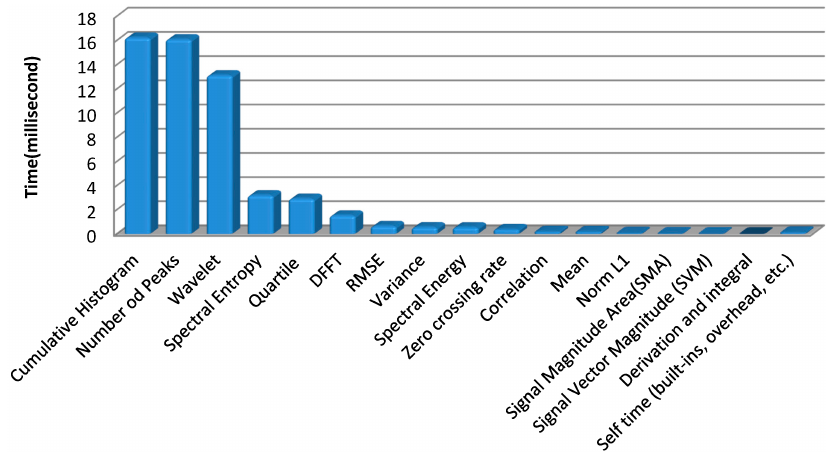
Figure 10. Time efficiency of feature extraction techniques on a window of 80 samples.